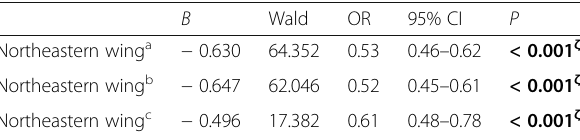
Table 3 Comparison of mental health between Northeastern wing and Southeastern wing of Chongqing